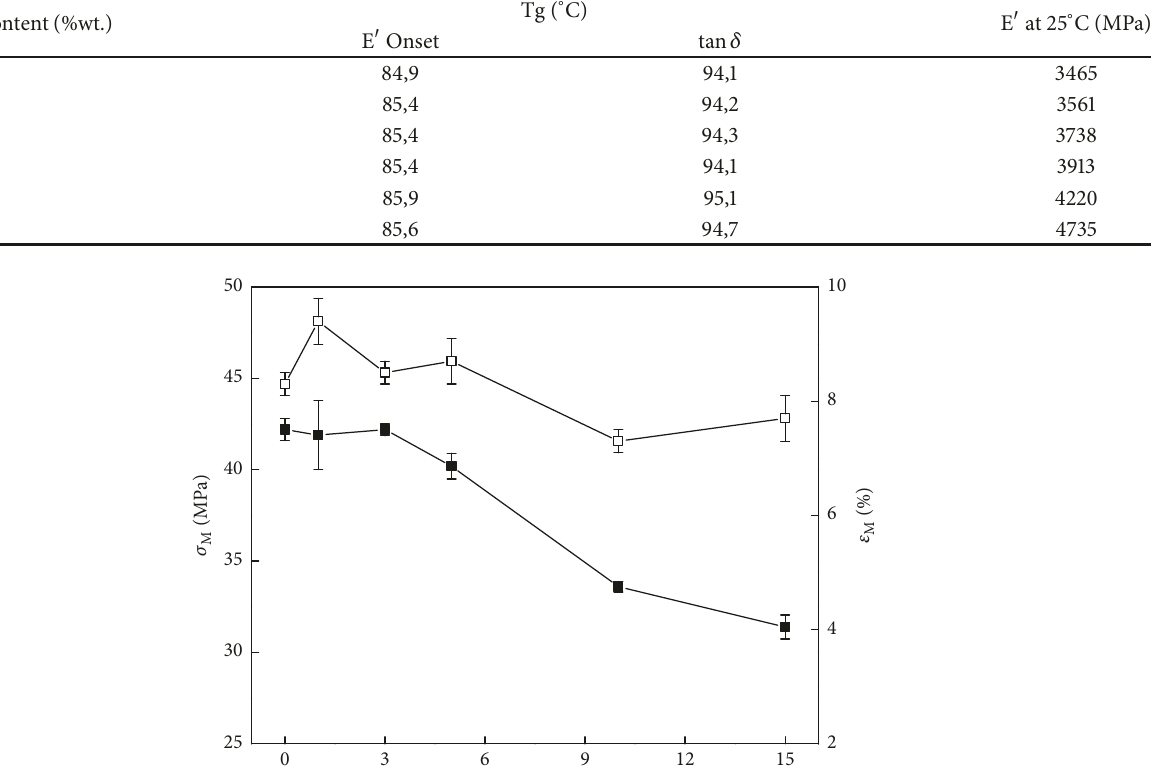
Figure 10: Tensile strength 𝜎